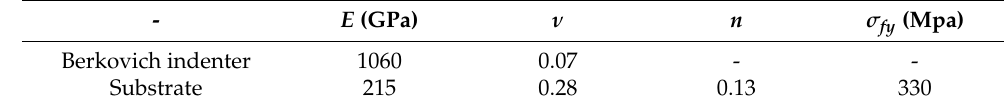
Table 1. Mechanical properties for indenter and substrate.